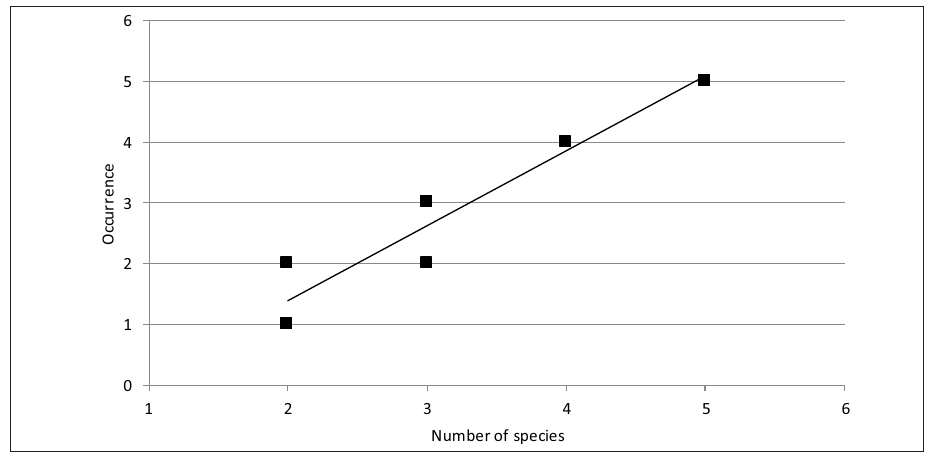
Figure 1: The number of medium and large Bovidae and Equidae species and occurrences at Kromdraai B, Sterkfontein Member 5, Swartkrans Members 1, 2 and 3, Drimolen and Cooper’s D Cave. Trend line